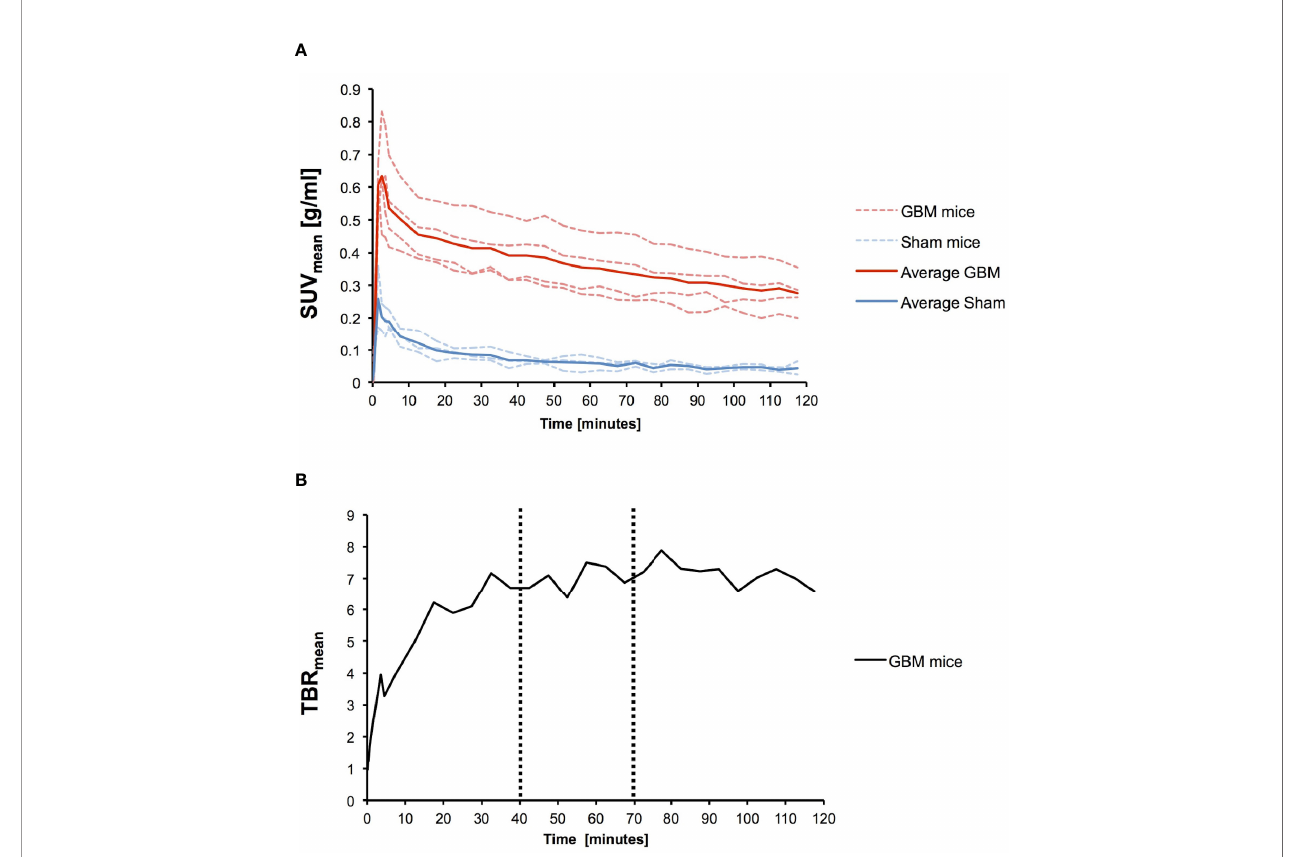
FIGURE 3 | Time-activity-curves (TAC). (A) Individual TACs for n = 4 GBM (red dotted line) mice and n = 3 sham mice (blue dotted line) as well as the average SUVmean for GBM (red solid line) and sham mice (blue solid line) are given. (B) TBR mean increased and stabilized after 40 min (max. 7.9 at 77.5 min). Therefore a 40-70 min time frame was chosen for further static